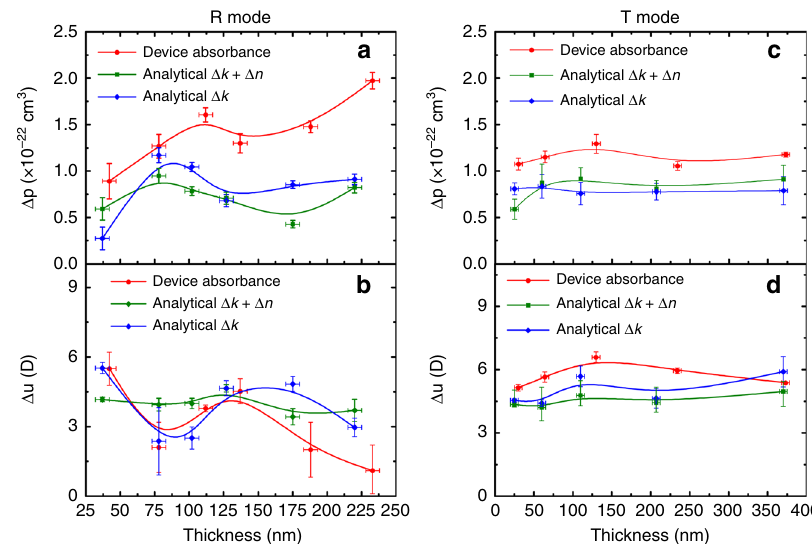
Fig. 7 Δ p and Δ u vs. thickness of different fi tting approaches. The error bar in the x -axis represents the statistical standard deviation ±5 nm of the thickness determined by pro fi lometer. The error bar in the y-axis represents the statistical standard deviation of the possible fi tting values. a , b Re fl ection (R) mode thickness dependence of Δ p and Δ u . c , d Transmission (T) mode thickness dependence of Δ p and Δ u . Analytical Δ k + Δ n represents both the active layer ’ s electroabsorption and electrorefraction are considered. Analytical Δ k represents only the active layer ’ s electroabsorption signal is considered